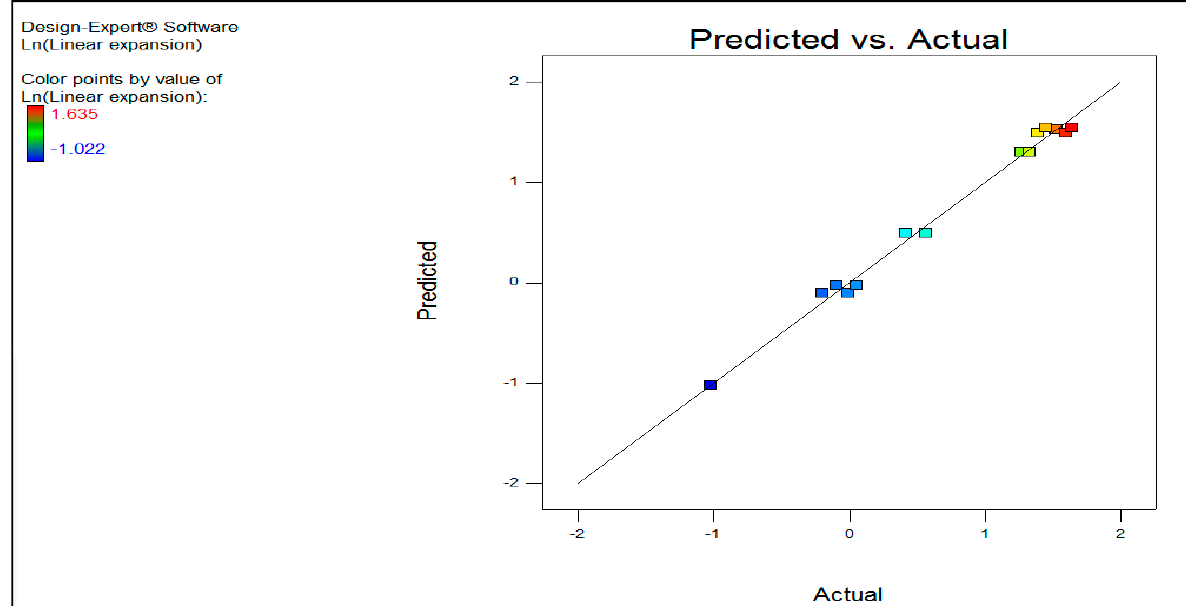
Figure 11. Predicted versus actual.